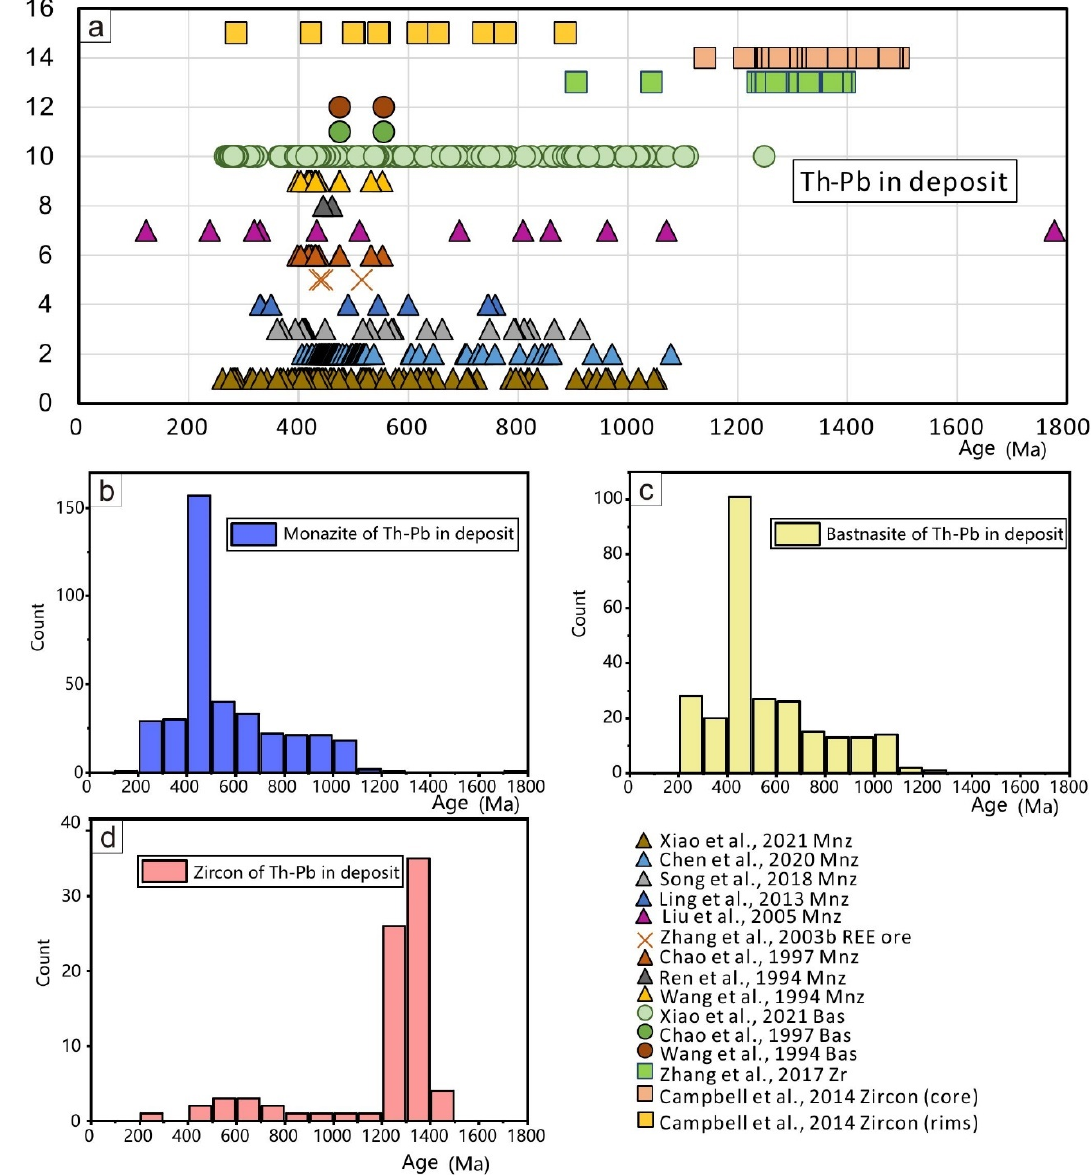
Figure 17. Age distribution characteristics of Th–Pb in the ore deposit. ( a ) Single age distribution characteristics corresponding to different studies. ( b – d ) Stack histograms of all ages [6–8,17,34,46,54–58]. The range and peak Th–Pb age distribution of monazite and bastnaesite in the ore body are basically the same, with peak values of ~0.4–0.5 Ga and ranges of ~0.2–1.3 Ga, sug- gesting that their formation periods are consistent. From the slate ages, a